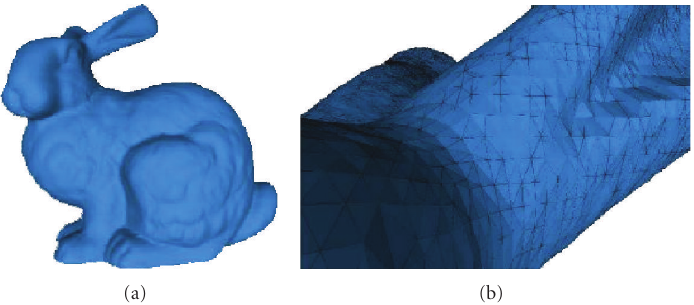
Figure 3: (a) Bunny of stanford . (b) Zoom on the ears of the bunny.